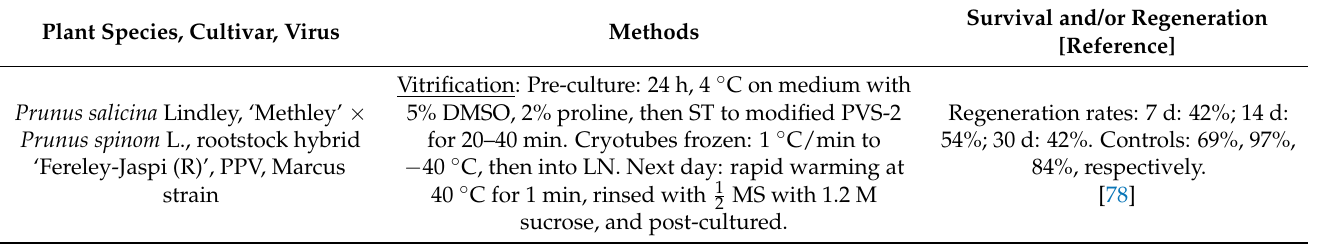
Table 2. Results and methodology of cryotherapy experiments. Plant Species, Cultivar, Virus